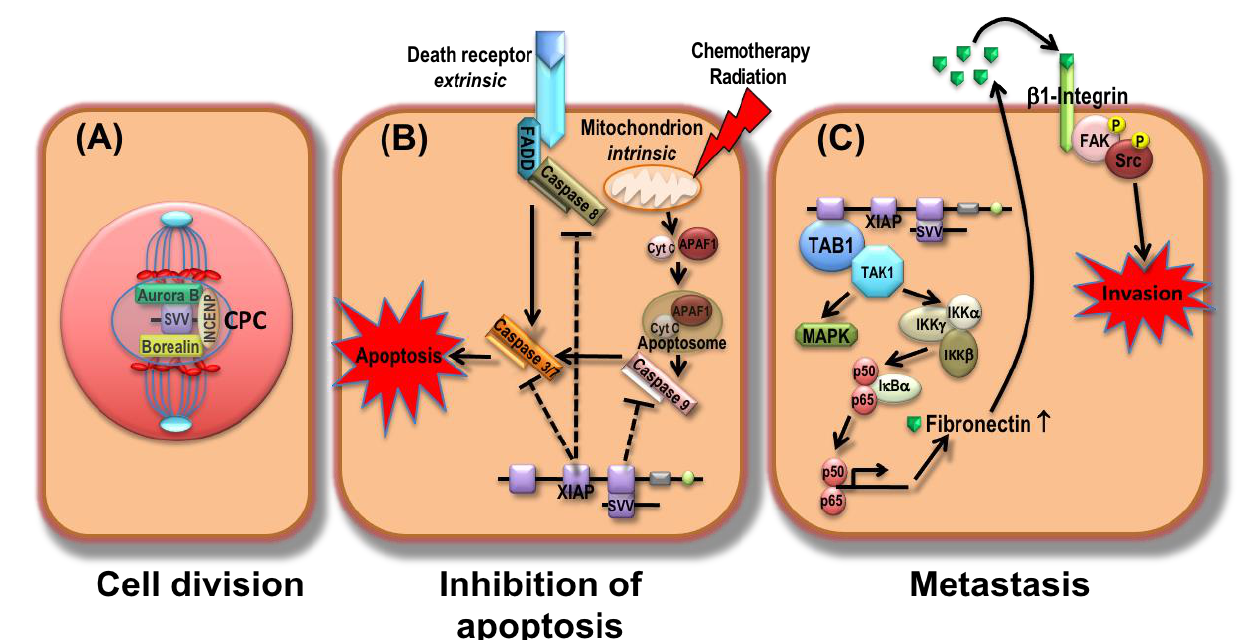
Figure 1. Schematic representation of survivin actions. ( A ) During cell division, survivin (SVV) forms with Aurora B, Borealin, and INCENP (inner centromere protein), the chromosomal passenger complex (CPC) that regulates chromosome segregation and cytokinesis. By directly binding, survivin protects XIAP from proteosomal degradation. ( B ) The stabilized XIAP-survivin complex inhibits apoptosis mediated by caspases after the activation of intrinsic or extrinsic signaling pathways. FADD, FAS-associated death domain protein; Cyt c, cytochrome c; APAF1, apoptotic protease activating factor 1. ( C ) XIAP and survivin cooperate to activate transcription factor NF- κ B via the TAB1/TAK1 complex, which induces the overexpression of fibronectin 1. This leads to an autocrine or paracrine stimulation of β 1-integrin and phyosphorylation (P) of proto-oncogene tyrosine kinase Src and focal adhesion kinase FAK. Activation of these cell motility kinases induces metastasis by activating tumor cell invasion.